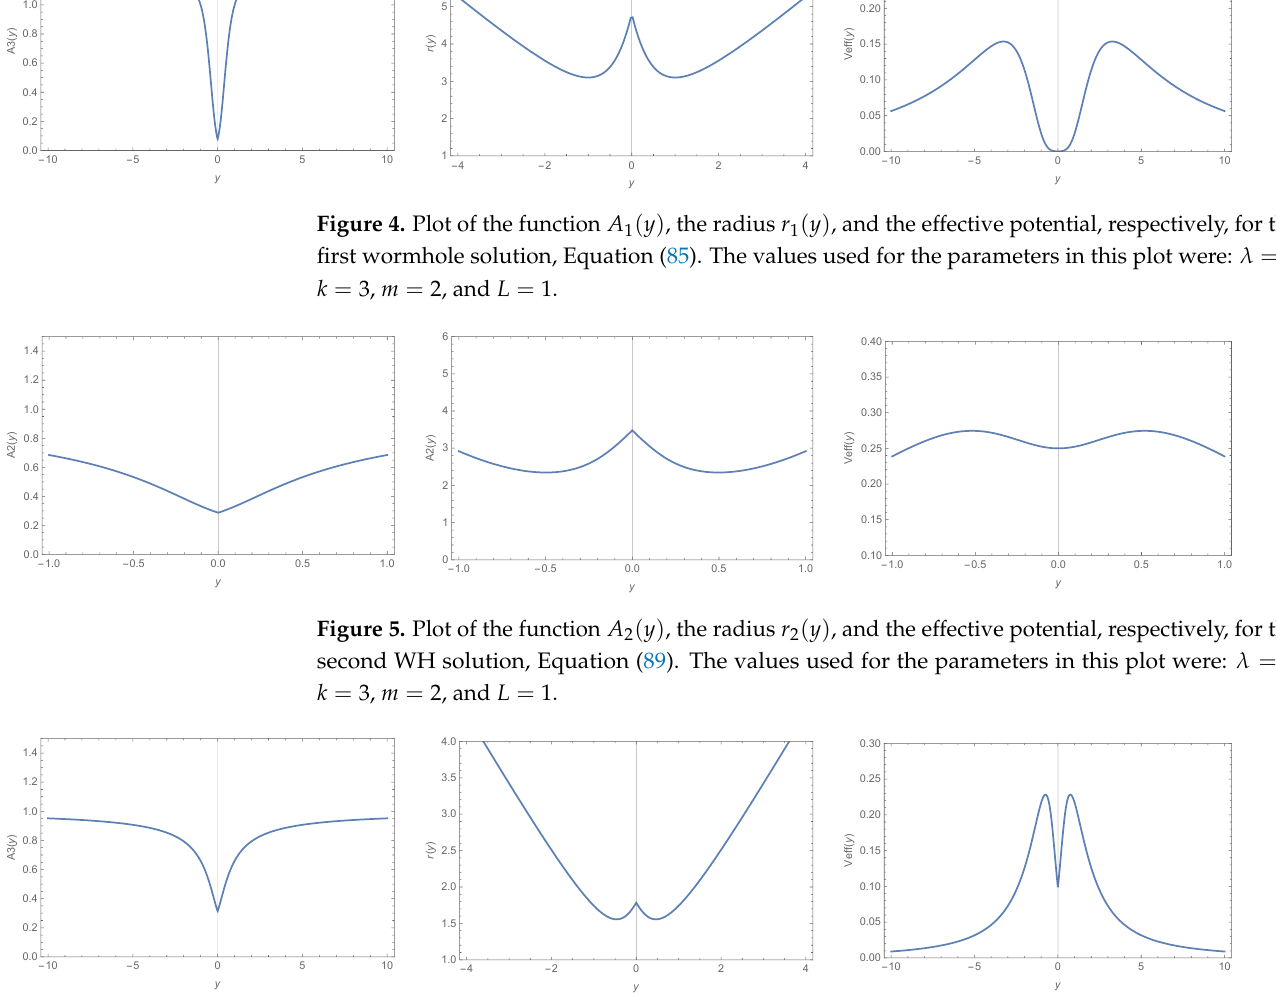
Figure 6. Plot of the function A 3 ( y ) , the radius r 3 ( y ) , and the effective potential, respectively, for the third WH solution, Equation (92). The values used for the parameters in this plot were: k = 3, m = 1, and L =